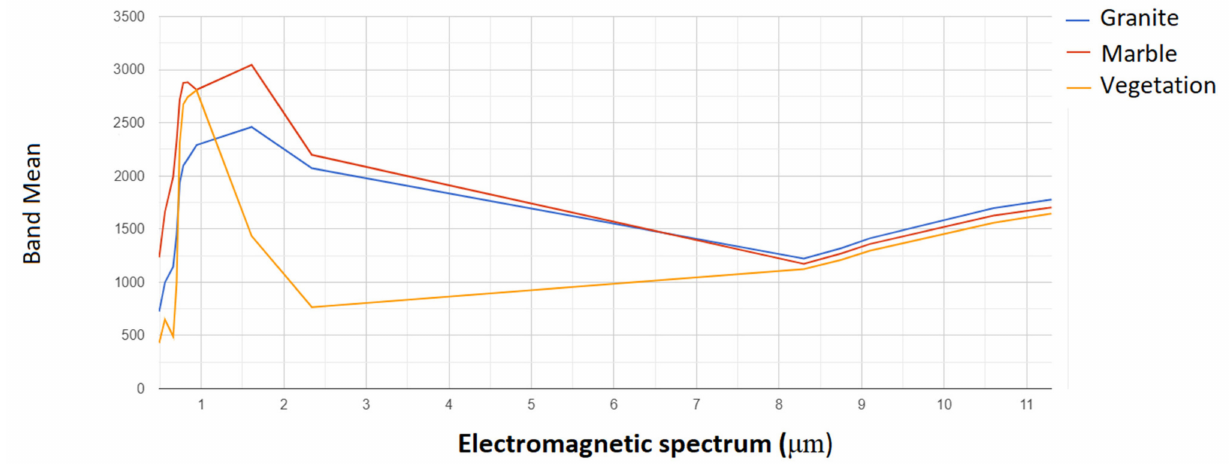
Figure 5. Spectral profiles of granite, marble, and vegetation in Shewa Shahbazgarhi